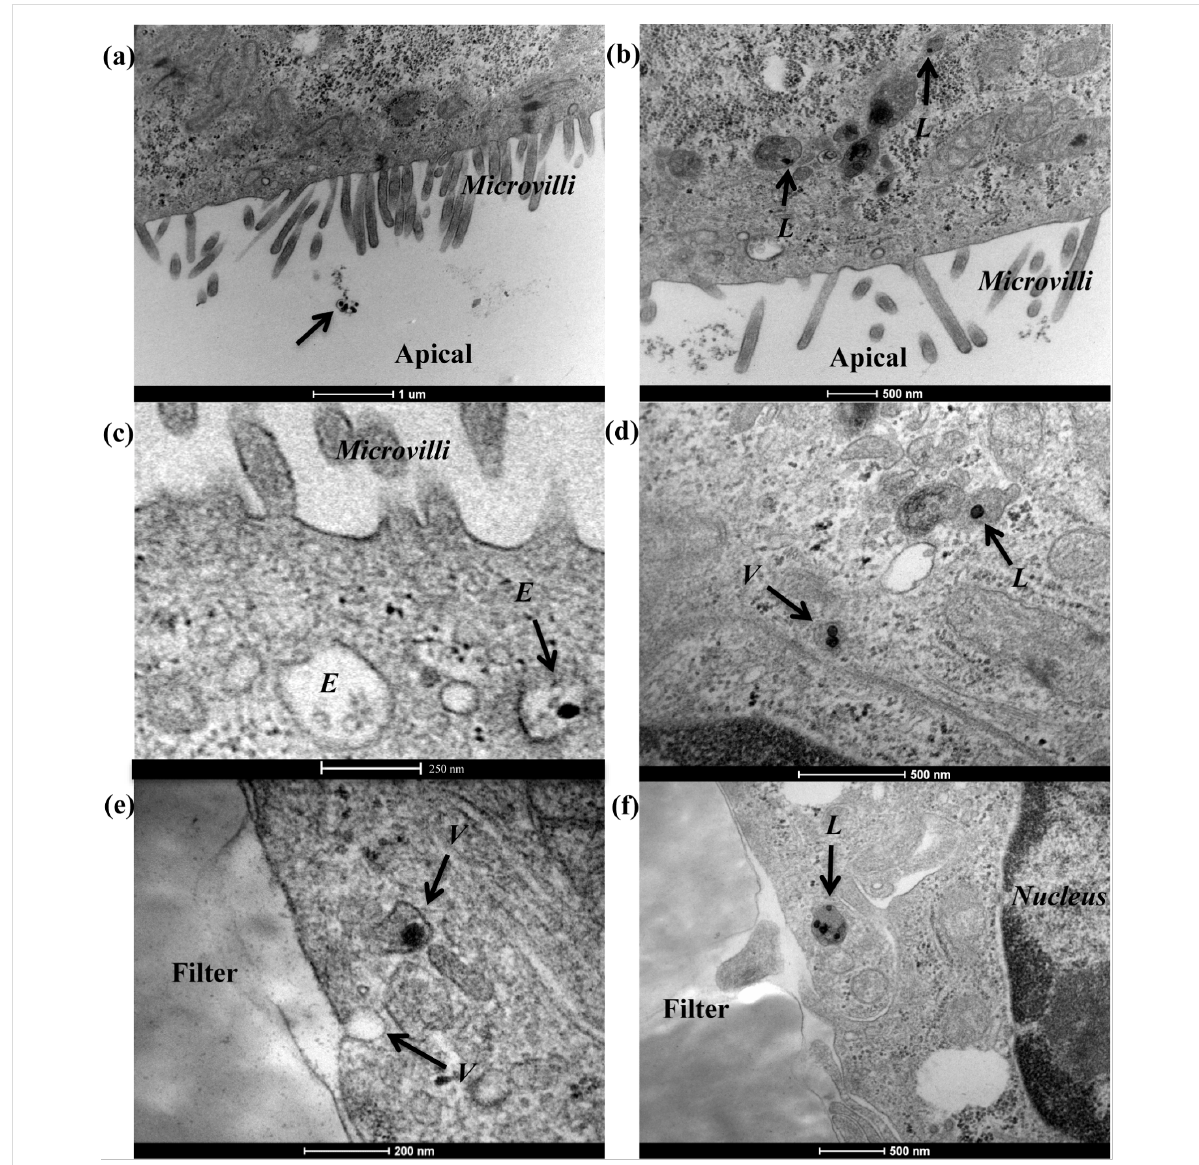
Figure 3: Transmission electron micrographs of Caco-2 barriers after exposure to 50 nm SiO 2 -NPs. Caco-2 barriers cultured for 21 days were exposed for 9 h to 100 µg/mL 50 nm SiO 2 -NPs dispersed in (a,b) the absence of serum, and (c–f) the presence of 10% FBS. The arrows indicate some extracellular NPs and a few NPs observed inside the cells in different vesicles along the endolysosomal pathway. Abbreviations: E , endosome; L , lysosome; V , vesicle.